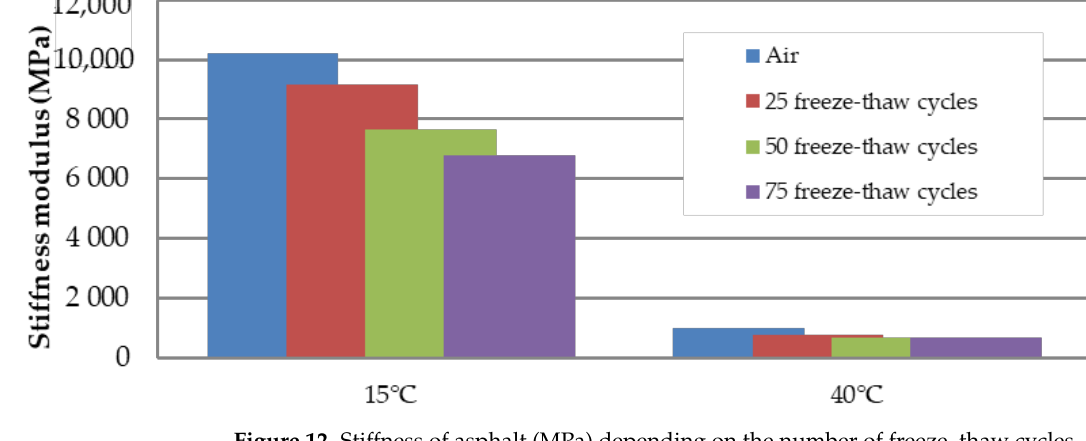
Figure 11. Stiffness modulus test (Photo: Authors).